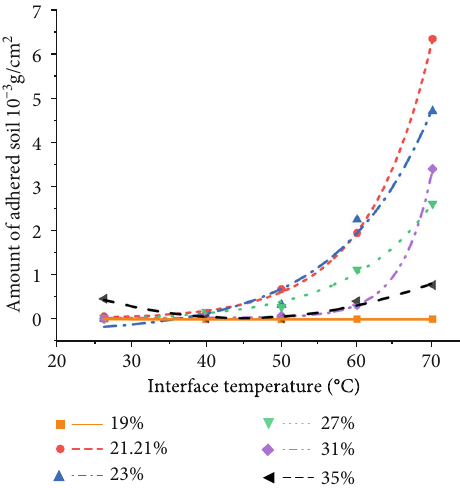
Figure 6: The relationship between the interface temperature and the amount of adhered